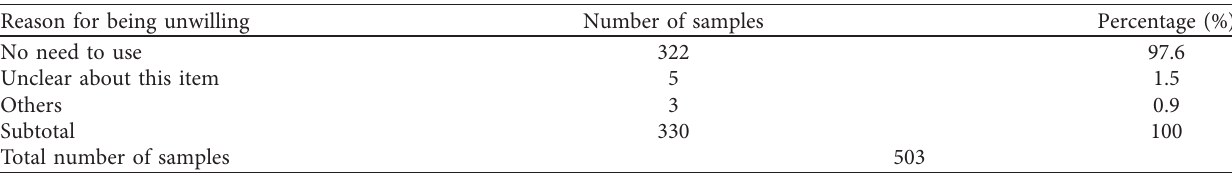
Table 5: Reasons for being unwilling to make additional purchases in the questionnaire scenario.